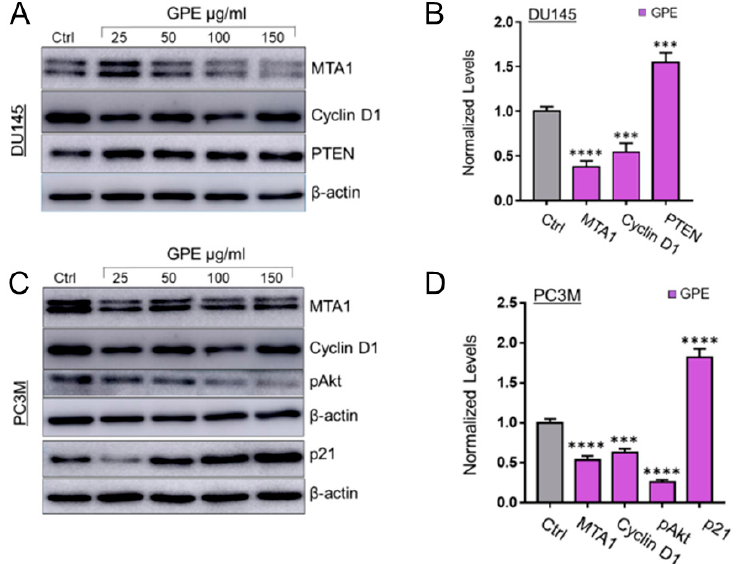
Figure 5. Effects of GPE treatment on MTA1-associated protein levels. ( A ) Immunoblots of MTA1, Cyclin D1, and PTEN expression, in DU145 cells treated with GPE. β -actin was used as a loading control. ( B ) Quantitation of immunoblot signals of MTA1-associated proteins, Cyclin D1, and PTEN, in cells treated with 150 µ g/mL GPE. ( C ) Immunoblots of MTA1, Cyclin D1, pAkt, and p21 expression, in PC3M cells treated with GPE. β -actin was used as a loading control. ( D ) Quantitation of immunoblot signals of MTA1-associated proteins, Cyclin D1, pAkt, and p21, in cells treated with 150 µ g/mL GPE. Western blots were repeated three times for each protein, and representative blots are shown. *** p < 0.001 and **** p < 0.0001 (one-way ANOVA) were assessed as significant differences between 150 µ g/mL GPE-treated vs. Ctrl vehicle-treated cells.